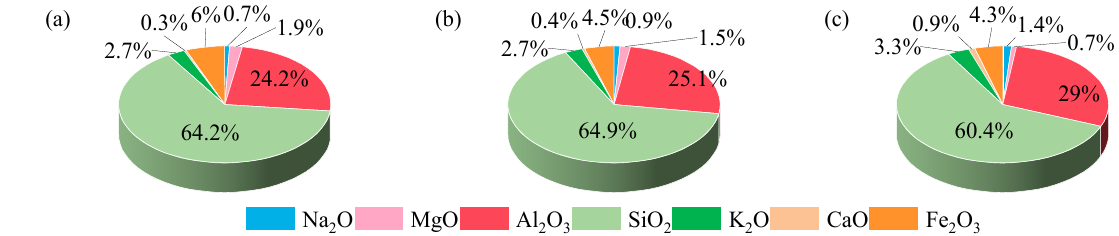
Figure 6. Chemical composition of the roof samples: ( a ) MS14; ( b ) MS15; ( c ) MCS16.